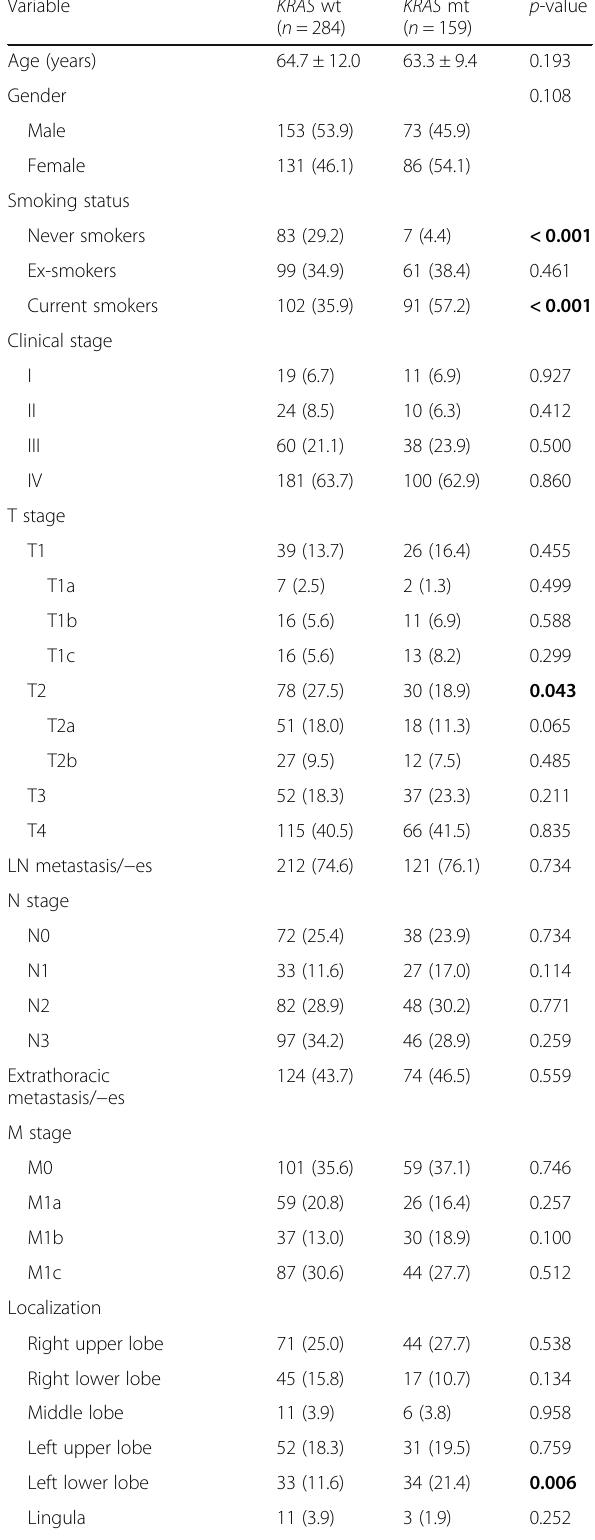
Table 6 Associations between clinicopathological features and KRAS mutational status Variable